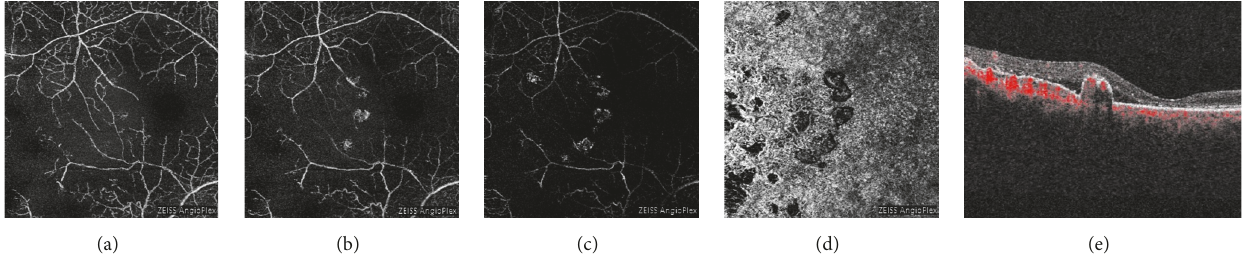
Figure 6: OCT-Angiography (OCT-A) images of the right eye at the 7-month follow-up time-point. The superficial (a) and deep (b) OCT-A slabs revealed macular ischaemia. The polyps were visible in (b), the avascular (c) and choriocapillaris (d) slabs. Flow within the polyps was seen on the cross-sectional OCT-A image